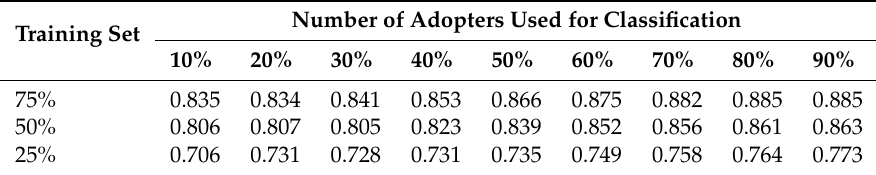
Table 5. Accuracy of classification results with the use of Experience Factors for 25%, 50%, 75% training set and 10%, 20%, ..., 90% of adopters used.